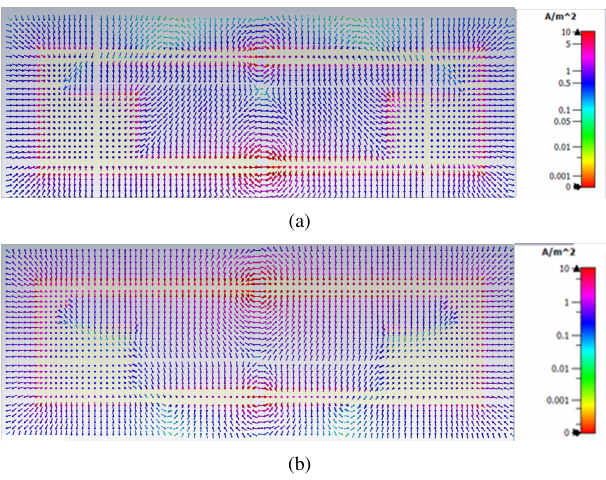
FIGURE 5: Surface current distributions. (a) Ant1 at 868 MHz, (b) ant2 at 915 MHz.